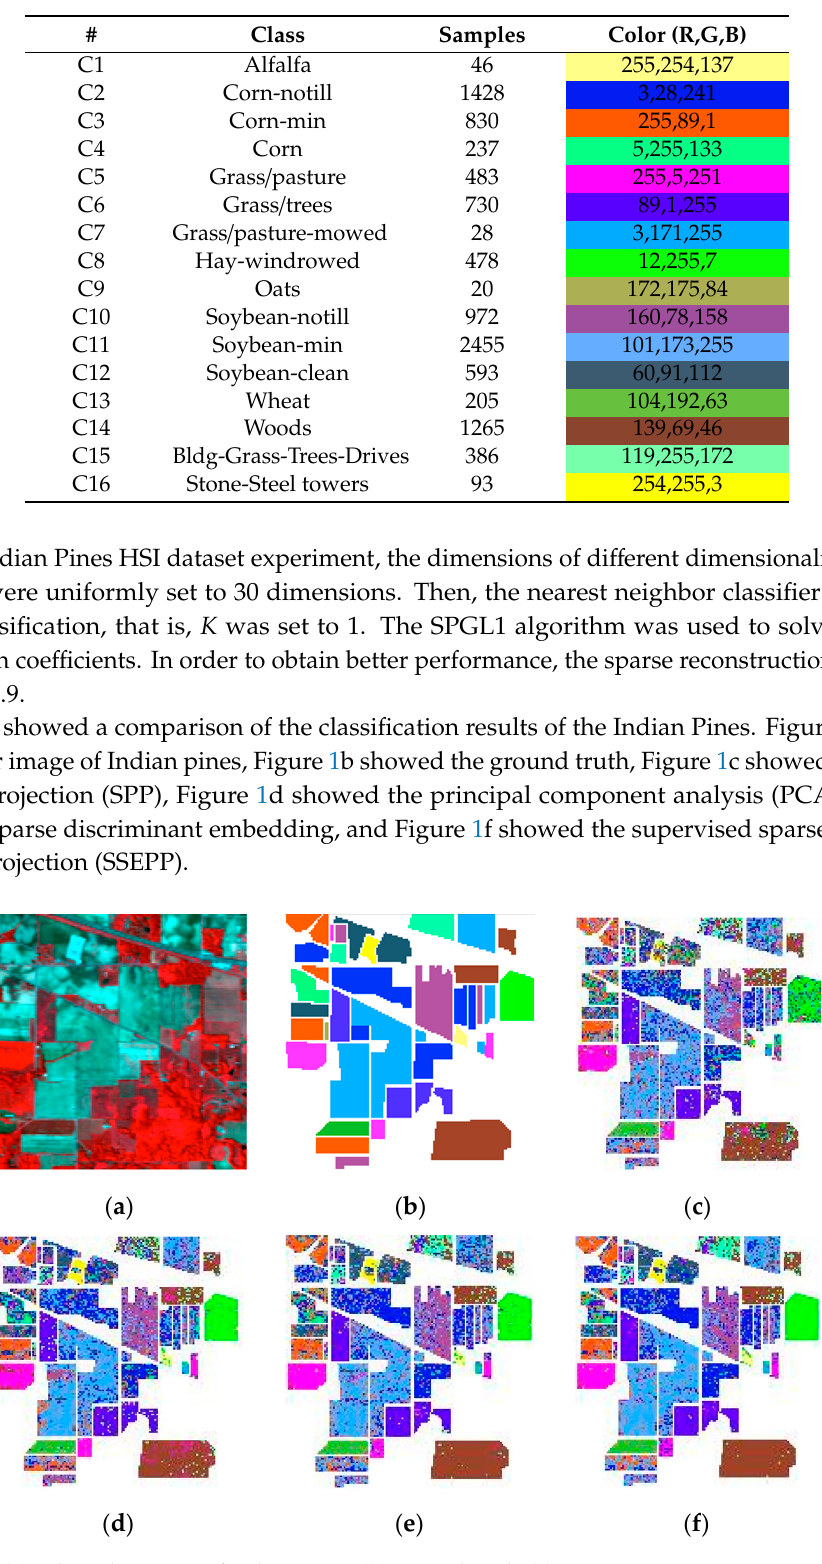
Figure 1. ( a ) False color image of Indian Pines; ( b ) ground truth; ( c ) sparsity preserving projection (SPP); ( d ) principal component analysis (PCA); ( e ) sparse discriminant embedding (SDE); and ( f ) supervised sparse embedding preserving projection (SSEPP).